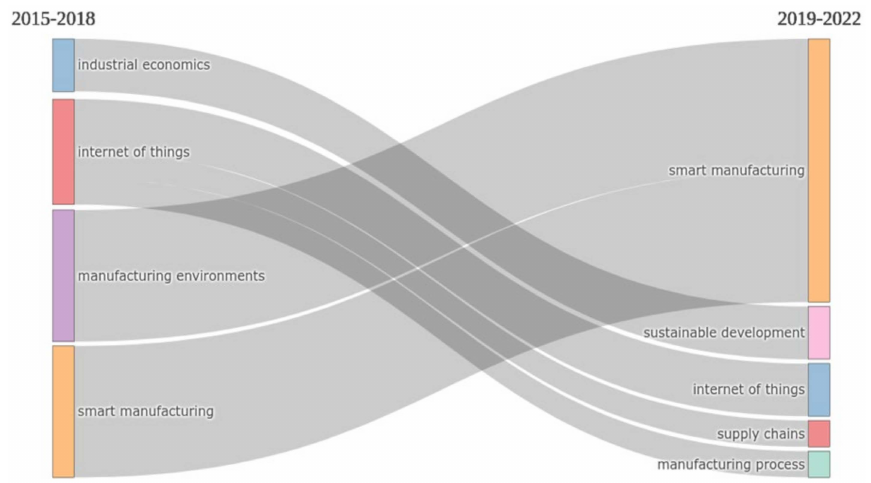
Figure 4. Thematic